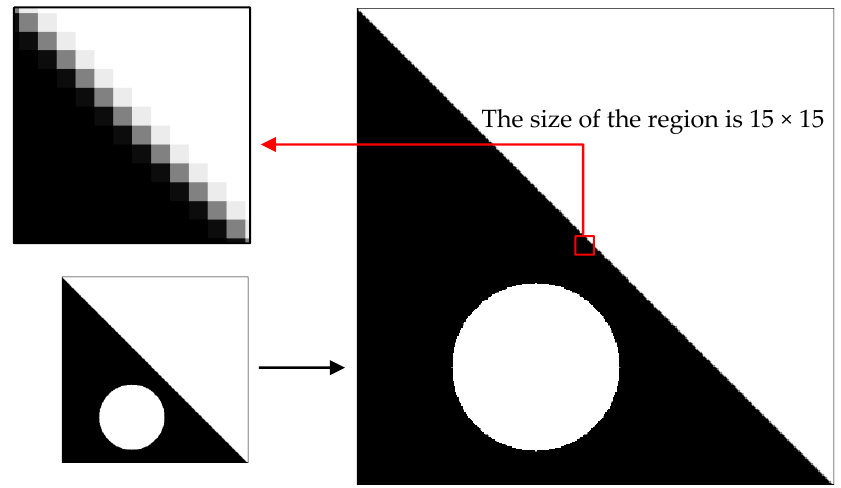
Figure 2. Selection process of knife-edge area. The resized image by resampling with multiples of k